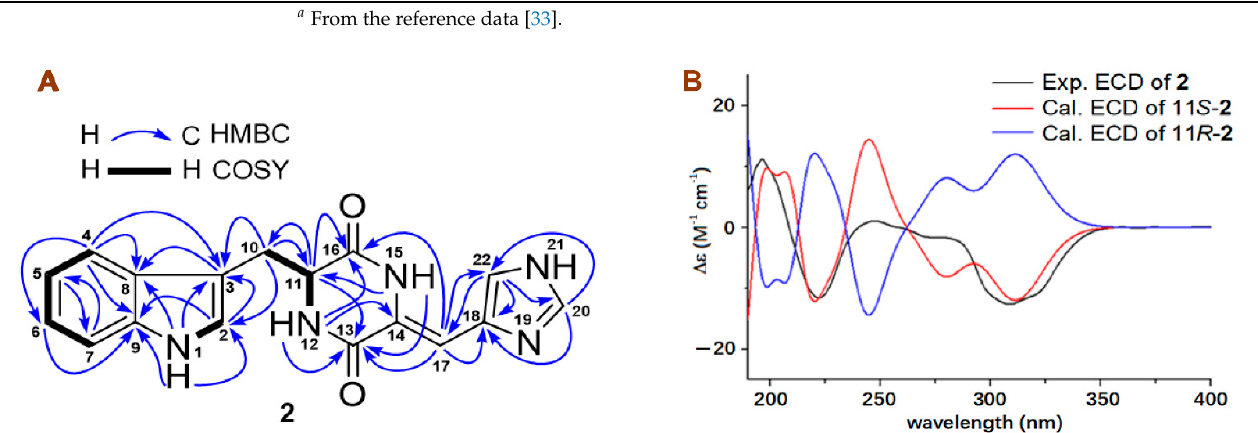
Figure 5. ( A ) COSY, key HMBC, and NOE correlations of 11 S -( − )-penilloid A ( 2 ) and the experimental ECD spectrum of 11 S -( − )-penilloid A ( 2 ) in MeOH; ( B ) The calculated ECD curves of two model molecules (11 S - 2 and 11 R - 2 ) at the b3lyp/6-311+g (d, p) level in MeOH.